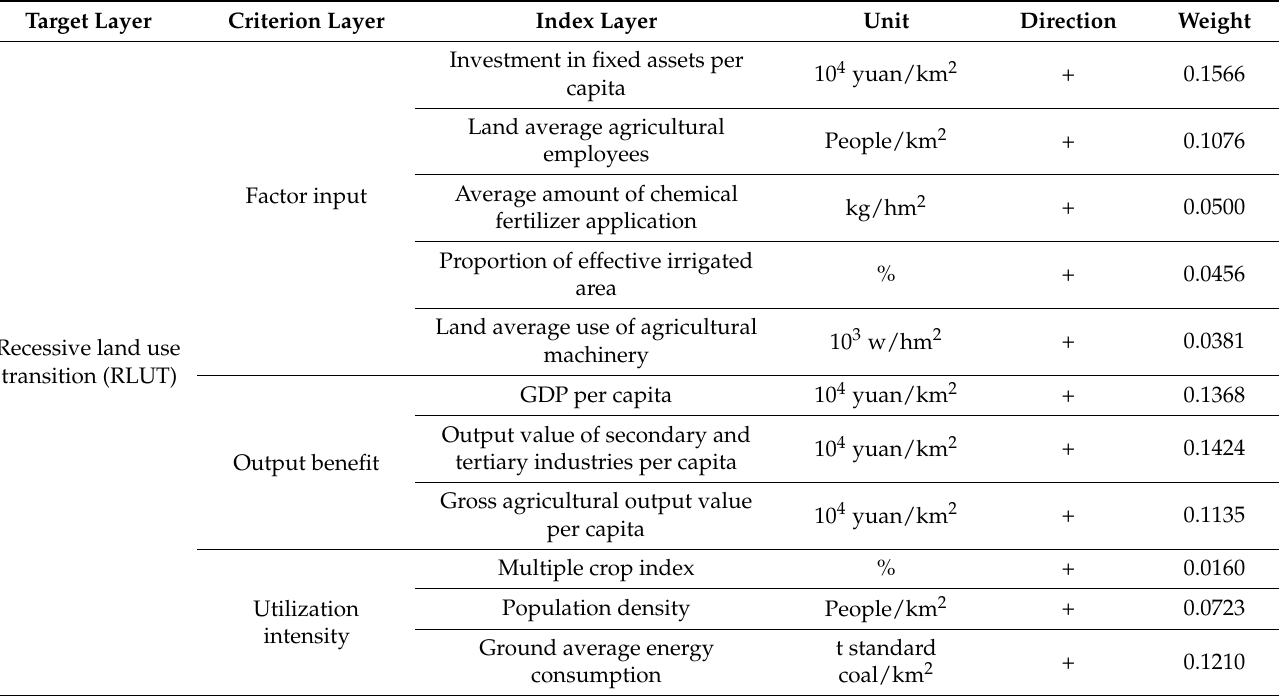
Table 1. Evaluation index system of RLUT.